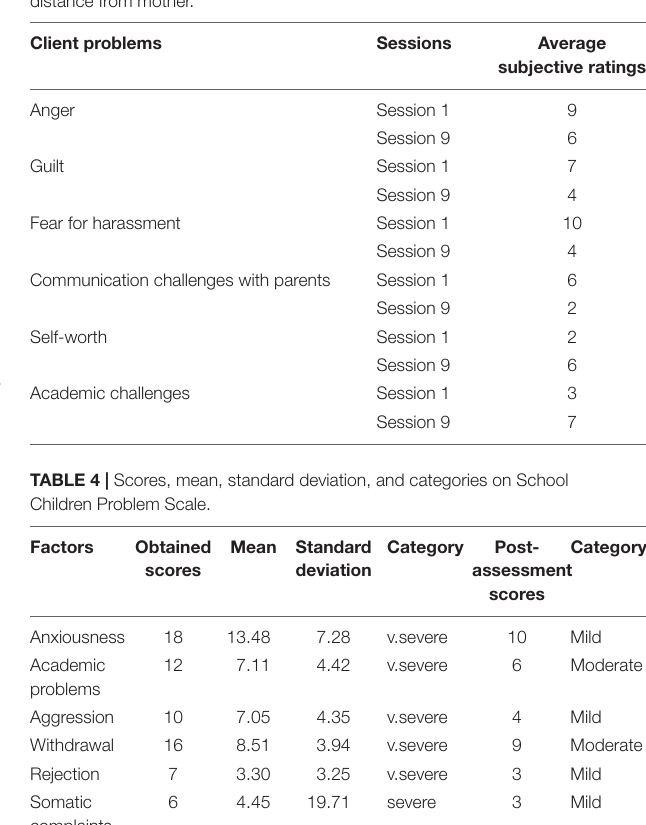
TABLE 3 | Subjective ratings of anger and guilt, fear, and emotional distance from mother.